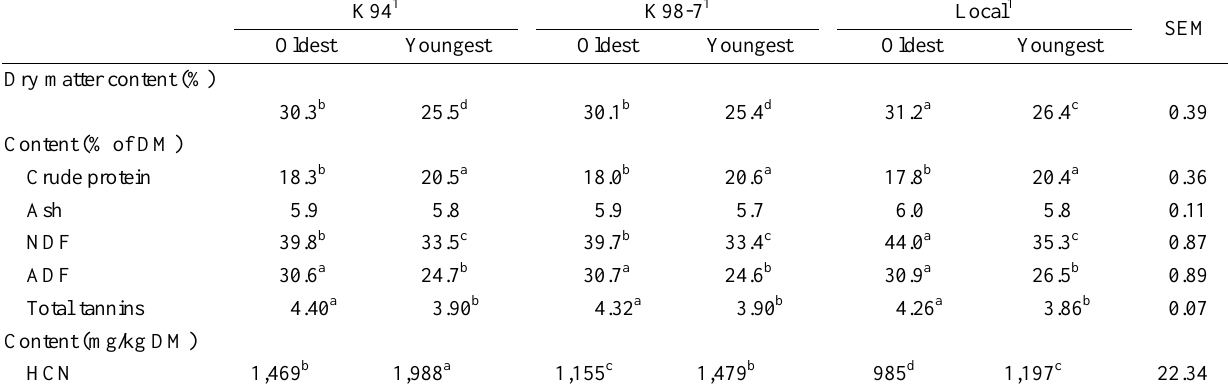
Least square means and standard error of means